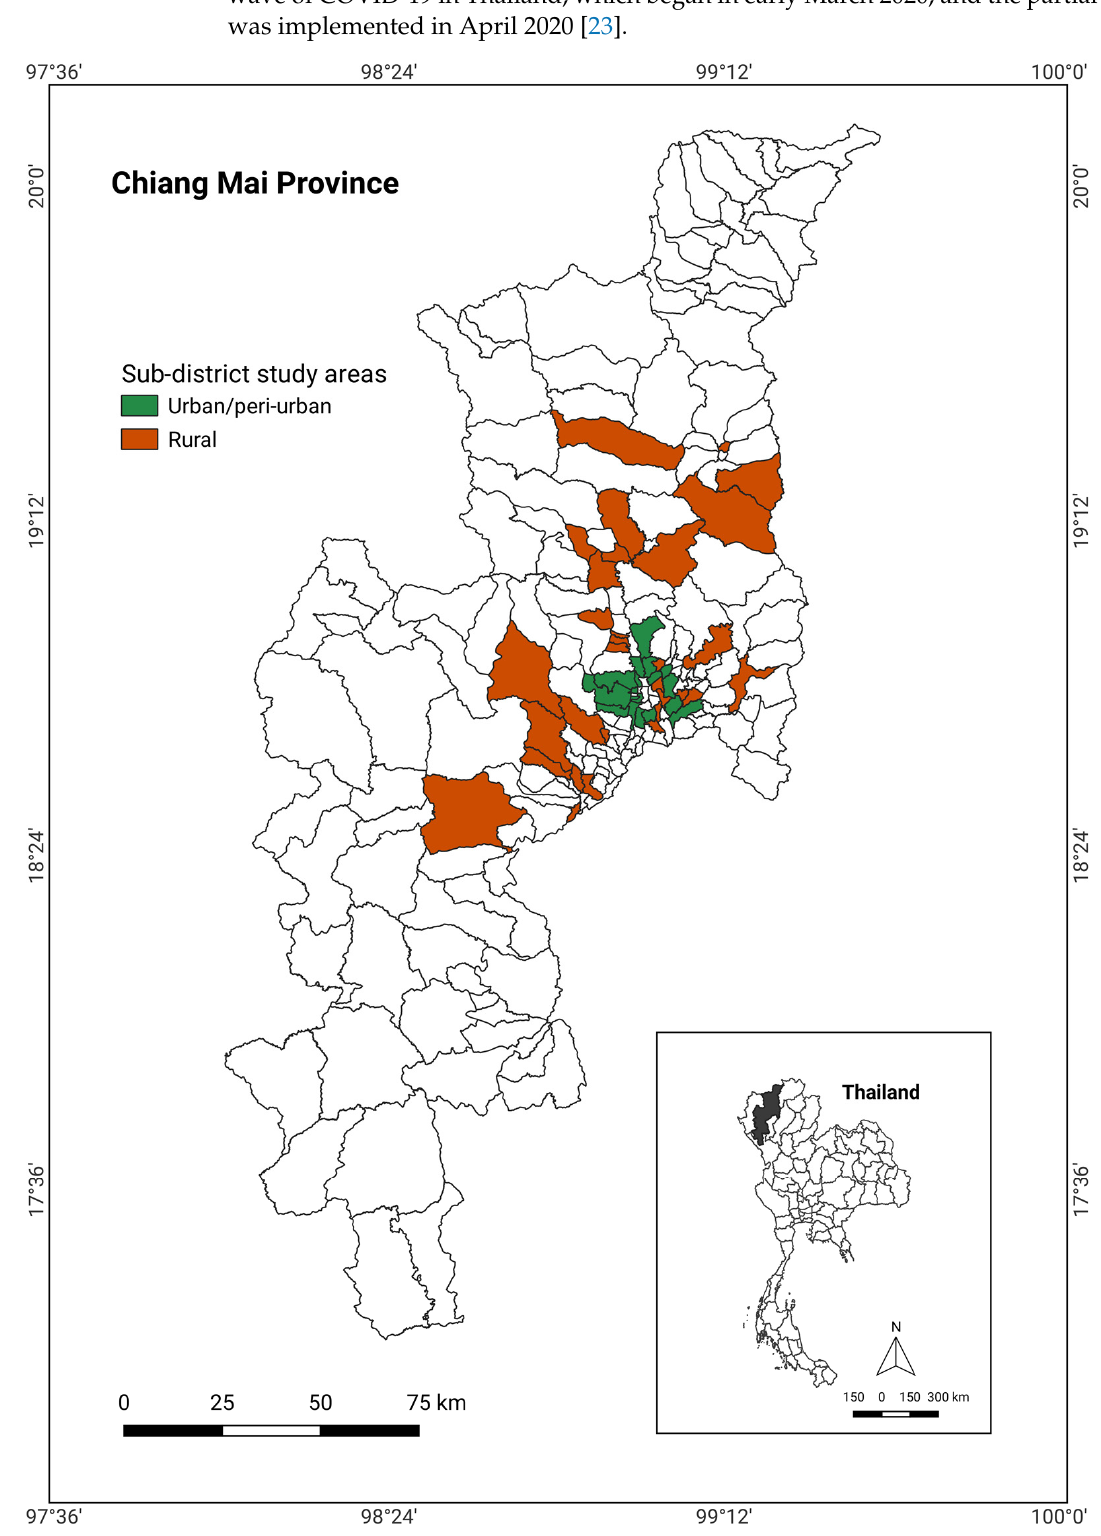
Figure 1. Subdistrict administrative map of Chiang Mai province.